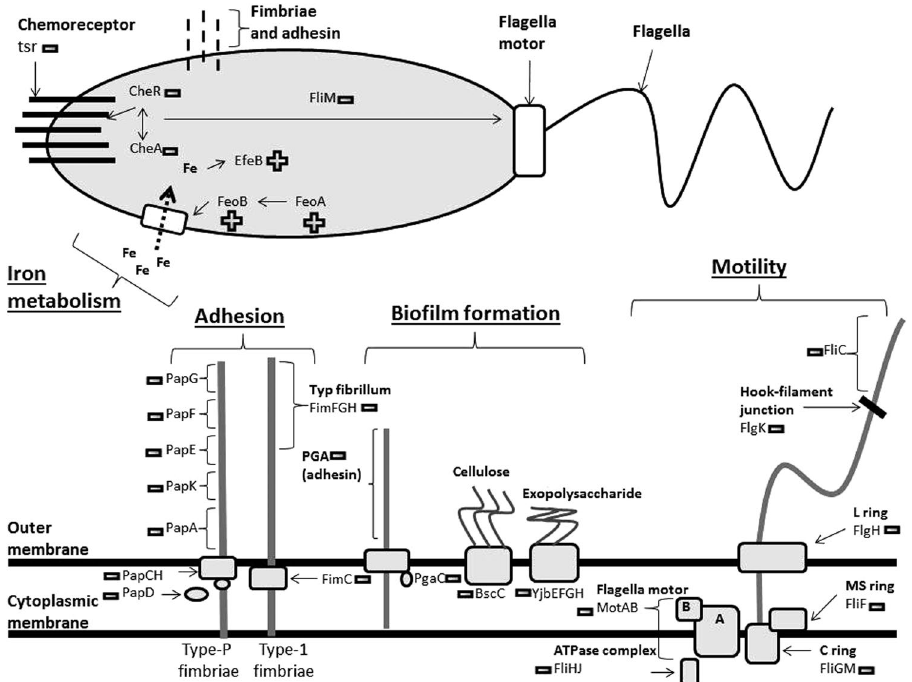
Figure 6. Simplified model for the metabolic pathways impacted by the association of cranberry ( Vaccinium macrocarpon ) and propolis. Genes related to adhesion, motility, iron metabolism and biofilm formation are represented with their variation: + corresponds to an up-regulation; − to a